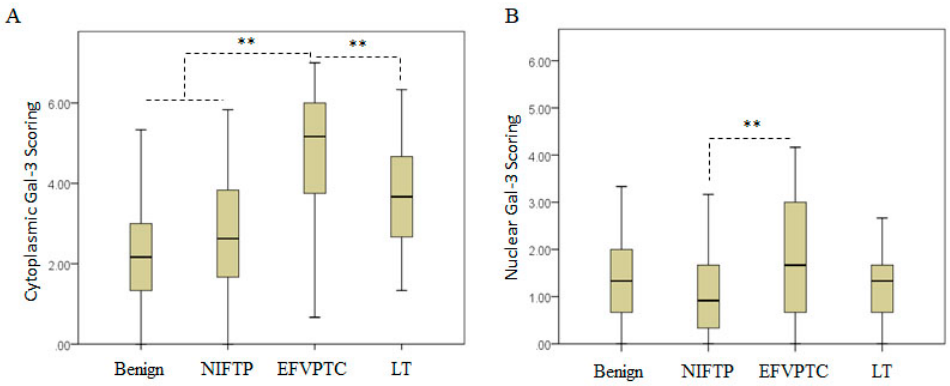
Figure 2. Distribution of Gal-3 expressions in Benign Nodules, NIFTP, EFVPTC and LT tissues. ( A ). Cytoplasmic Gal-3 expression; ( B ). Nuclear Gal-3 expression. The box-and-whisker plot showed the minimum, first quartile, median, third quartile and maximum of each group of data. Double stars (**) denoted a highly significant difference in means between groups at p < 0.01 (one-way ANOVA).